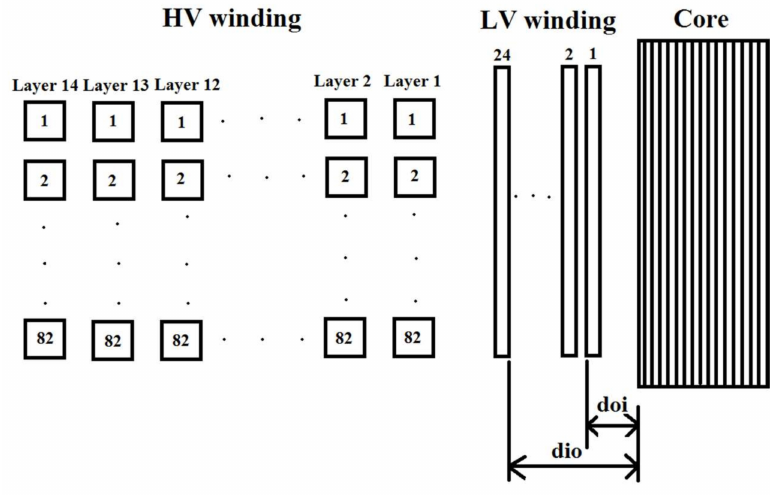
Figure 11. Sectional detail of the LV winding for a single